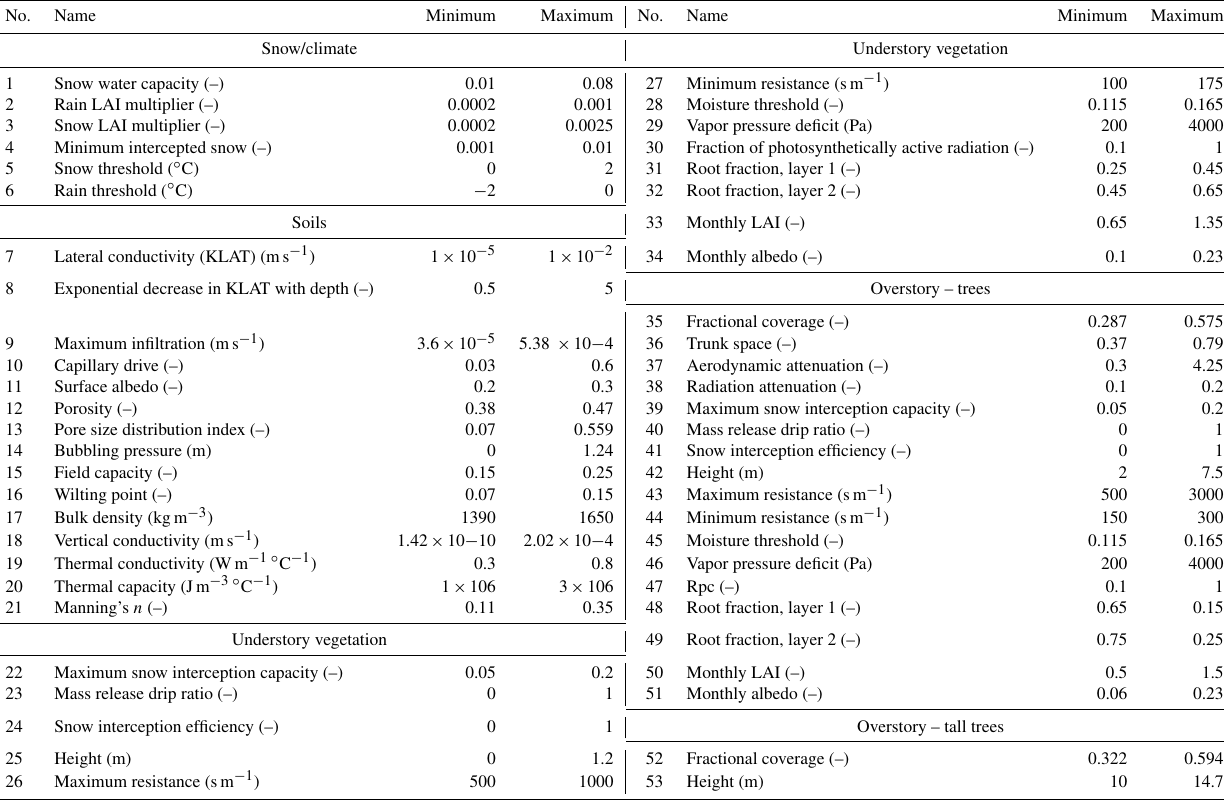
Table 1. Parameter types, names, numbers (with reference to Fig. 8), and ranges for all 53 parameters included in the analysis. Sources for ranges are detailed in Kelleher et al.